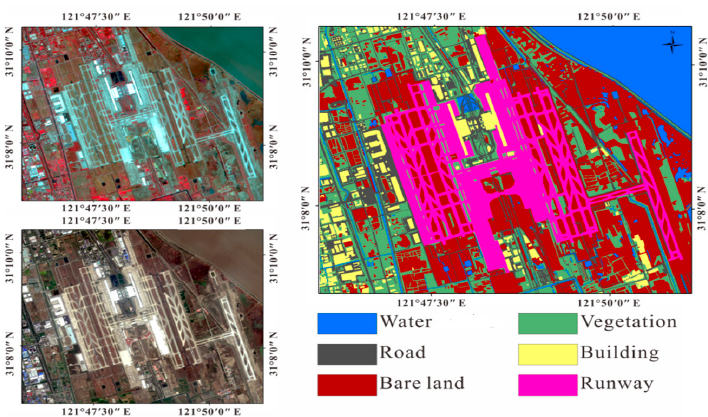
Figure 5. The top left is the standard false color composite image of Pudong International Airport (the acquisition date is 28 February 2017). The red channel is the 8th band. The green channel is the 4th band. The blue channel is the 3rd band. The spatial resolution is 10 m × 10 m. The bottom left is a true color image (the acquisition date is 28 February 2017). The red channel is the 4th band. The green channel is the 3rd band. The blue channel is the 2rd band. The spatial resolution is 10 m × 10 m. The right side is the result of visual interpretation (the spatial resolution is 10 m × 10 m).